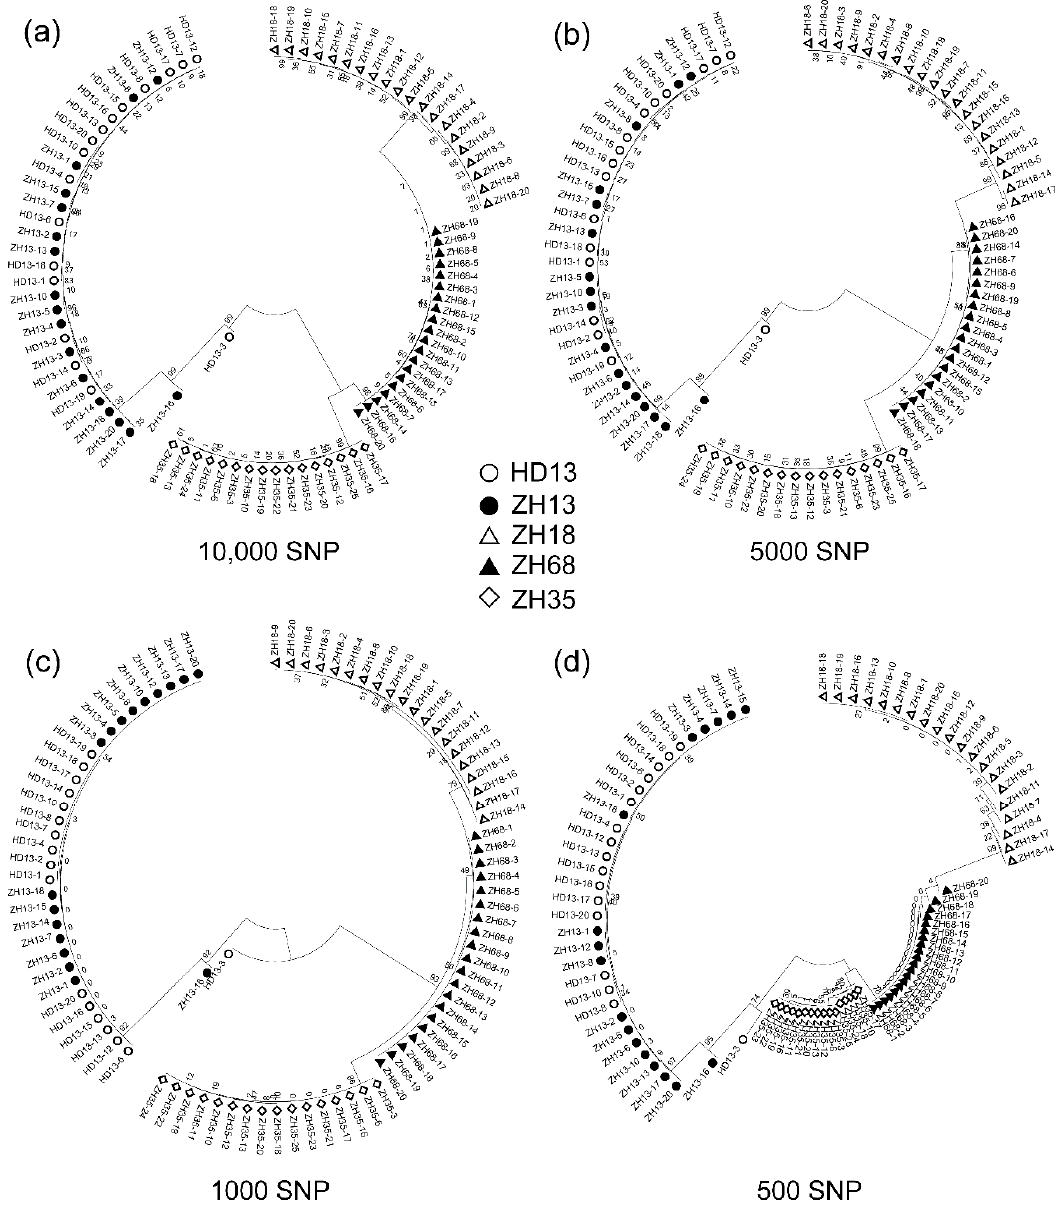
Figure 4. The phylogenetic analysis of the five soybean cultivars using the decreasing number of SNPs randomly picked from all the SNPs identified by SLAF-seq. ( a ) 10,000 SNPs; ( b ) 5000 SNPs; ( c ) 1000 SNPs; ( d ) 500 SNPs.